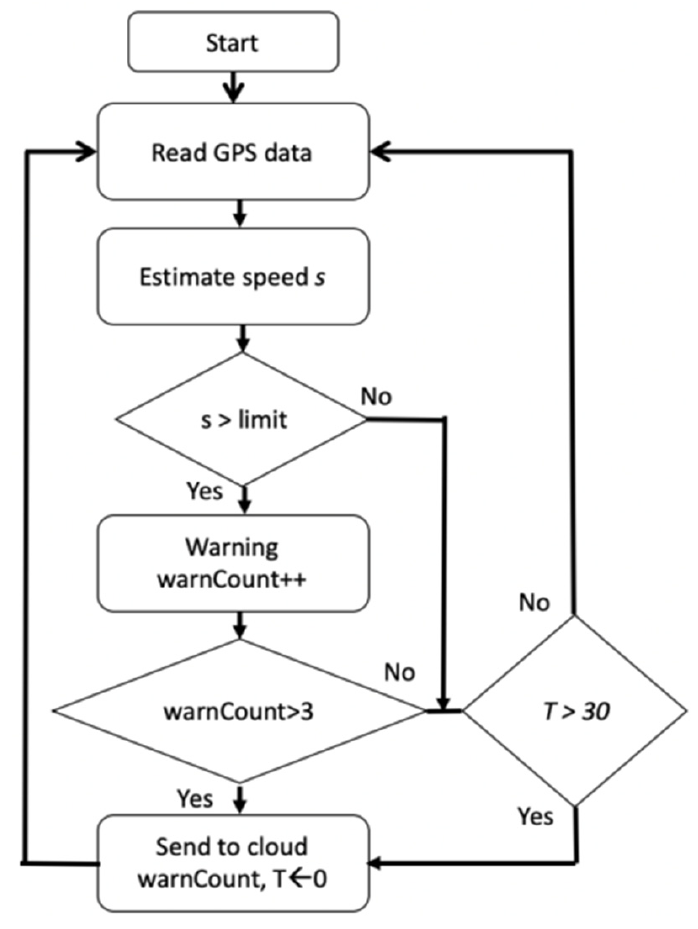
Figure 3. The flow chart of the speed monitoring algorithm in the fog layer. The algorithm estimates the speed using the Haversine function and warns the driver three times before sending the fine request to the cloud if the speed exceeds the permitted value.